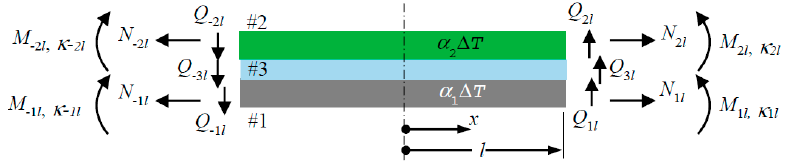
Figure 1. Schematic of a bonded structure experiencing general conditions of edge loading and thermal strain.